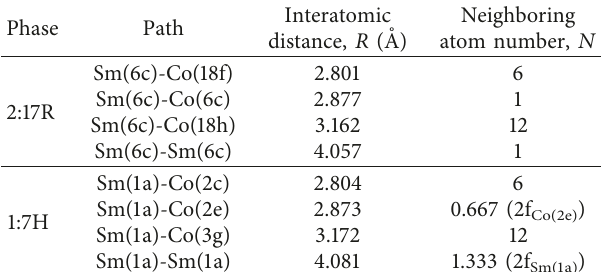
Figure 5: The standard atomic structures of 2:17R (a) and 1:7H (b). Co(6c), Co(18f), and Co(18h) represent Co at 6c, 18f, and 18h sites in 2:17R; similarly, the Co(2e), Co(2c), and Co(3g) represent Co at 2e, 2c, and 3g sites in 1:7H. Table 1: The neighboring atomic arrangements around Sm(6c) and Sm(1a) in standard 2:17R and 1:7H structures,